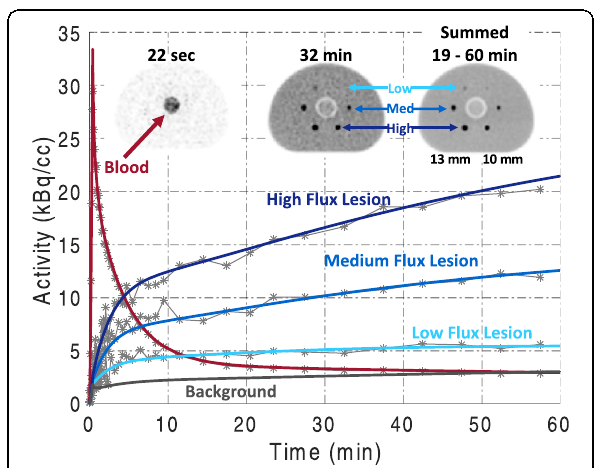
Fig. 1 (abstract A21). Ideal time activity curves for the blood, background, and lesions, with corresponding data curves shown in light grey ( ∗ ). The blood curve was derived from a small patient population and was used to fill the lung insert ( μ = water) of the simulated NEMA IEC phantom (top-left). The low, medium, and high flux curves were generated using kinetic parameters from literature [3] and were used to fill the 10- and 13-mm lesions (top right). The uptake in the background was based on data on muscle